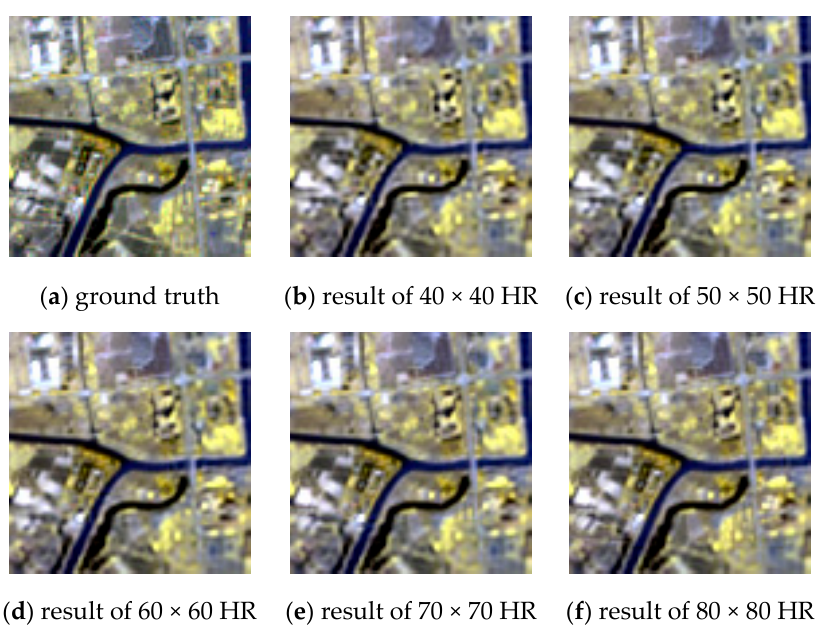
Figure 7. The results of the coverage ratio experiment.